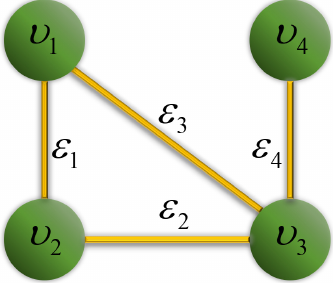
Figure 1. Connected